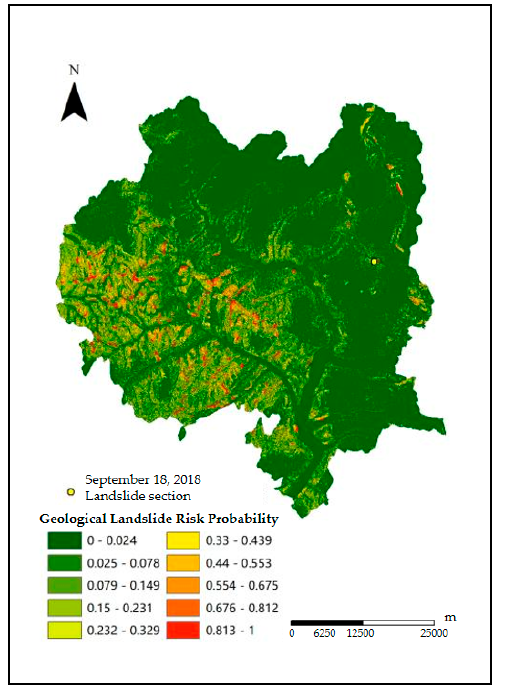
Figure 21. Map of landslide hazards in Xiji County based on multi-Graded Cascade Random Forest .